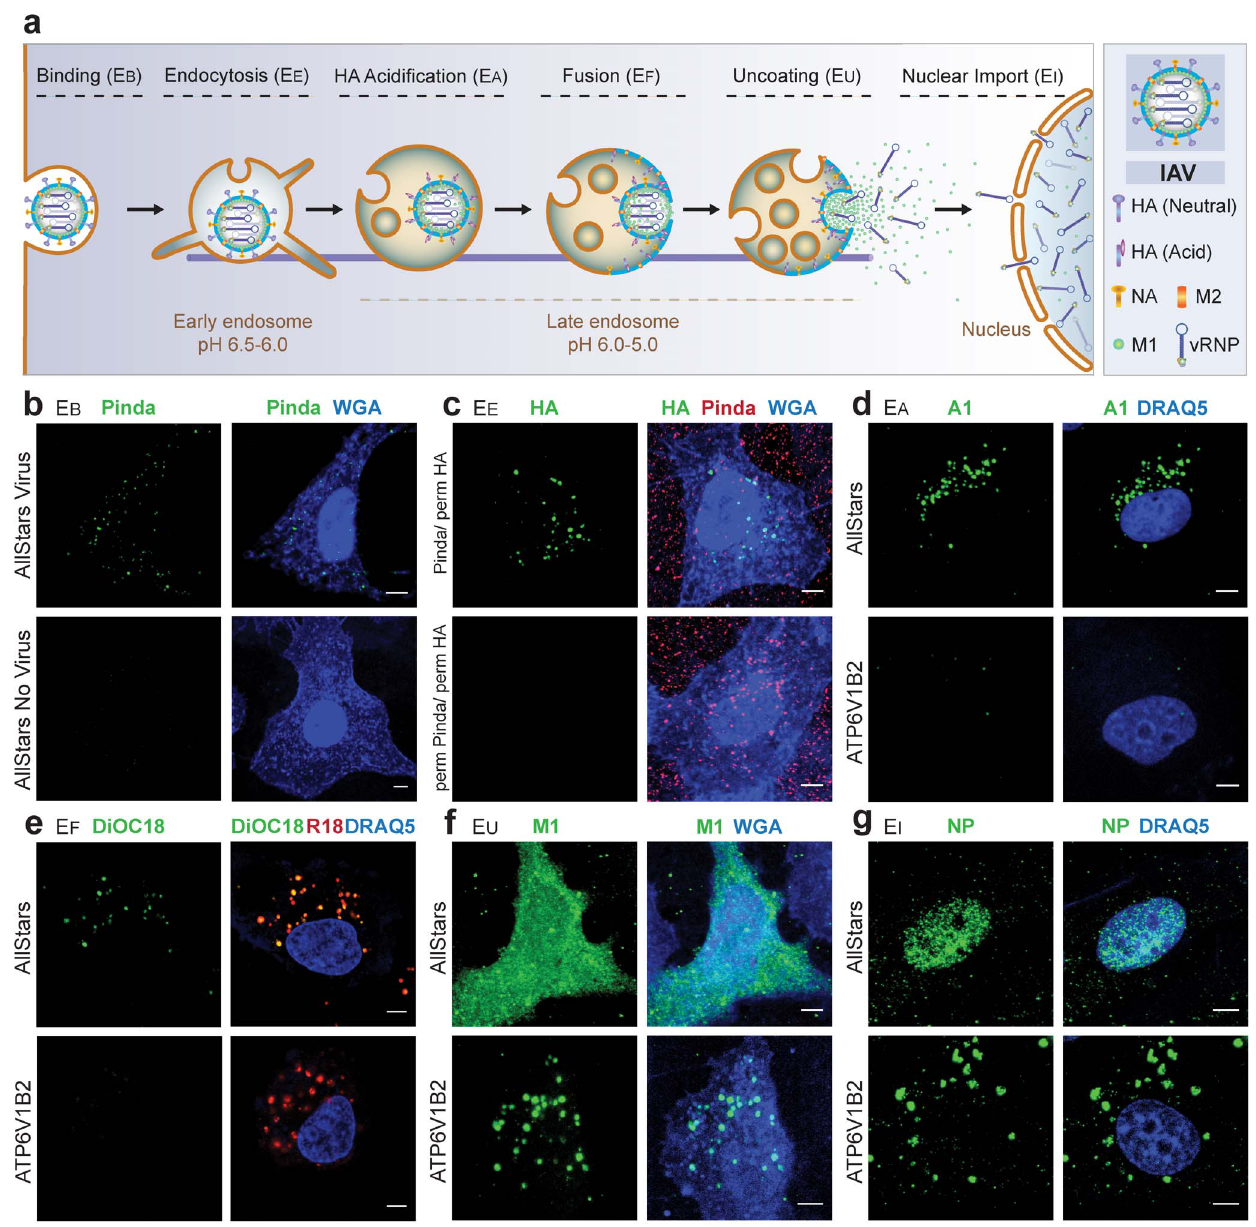
Figure 1. Sequential events during host-cell entry of IAV. (a). Entry involves six steps; binding of the virus to the cell membrane (EB), internalization by endocytosis (EE), acidification in late endocytic vacuoles (EA), fusion of viral and vacuolar membranes (EF), uncoating of nucleocapsid (EU), and nuclear import of vRNPs (EI). Components of IAV are shown in the right (NA: neuraminidase, M2: proton channel). (b–g). High- resolution confocal images of the individual assays. (b) Binding (EB assay): (Top) AllStars negative siRNA-treated cells were incubated with IAV for 1 h in the cold. After washing, cell-bound virus particles were stained by IIF using the Pinda antibody against HA (green). The cells membrane was visualized with WGA-AF647 (blue). ( Bottom ) Cells with no virus (c) Endocytosis (EE assay): (Top) Cells were incubated with IAV for 1 h in the cold. After washing, cells with bound viruses were warmed up to 37 u C for 20 min to allow virus internalization. To distinguish between the endocytosed and extracellular virus particles, the HA epitopes of the virus particles accessible from the medium were masked with the Pinda antibody. The cells were then permeabilized with detergent and incubated with a mouse monoclonal antibody (HA1). After fluorescently-labeled secondary antibody treatment, the endocytosed (green) and non-internalized virus particles (red) were identified (Pinda/perm HA). Cell membrane (blue) was stained with WGA. ( Bottom ) After virus internalization and fixation, cells were permeabilized with detergent and similar staining procedures were followed. The endocytosed and extracellular virus particles are not distinguished and both showed same fluorescent signal (red) (perm Pinda/perm HA). (d) Acidification (EA assay): (Top) Virus particles were allowed to enter the AllStars negative siRNA-treated cells at 37 u C for 1.0 h and were stained with A1 antibody to detect the acid-induced conformation of HA (green) in endocytic vacuoles near the nucleus (blue). ( Bottom ) Cells treated with ATP6V1B2 siRNA showed no A1 signal due to block in endosome acidification. (e) Fusion (EF assay): (Top) Virus particles were labeled with SP-DiOC18 (3) and R18, and were allowed to enter the AllStars negative siRNA-treated cells at 37 u C for 1.5 h, after which the cells were fixed. Fusion of viral and vacuolar membranes of cells triggered dequenching of DiOC18(3) (green). DiOC18(3) signal colocalized with the R18 (red) signal. ( Bottom ) Cells treated with ATP6V1B2 siRNA showed R18 (red) signal only. (f) Uncoating (EU assay): (Top) To detect the dispersal of M1 into the cytoplasm of the cells (blue), viruses were allowed to enter the AllStars negative siRNA treated cells at 37 u C for 3 h. After fixation and permeabilization, mouse monoclonal